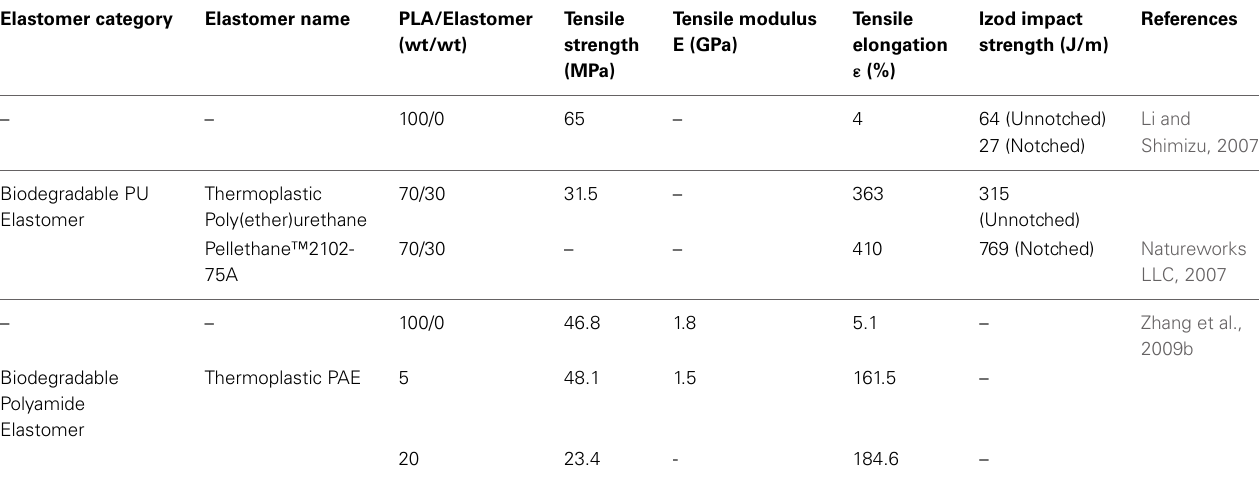
Table 7 | Blends with biodegradable elastomers and